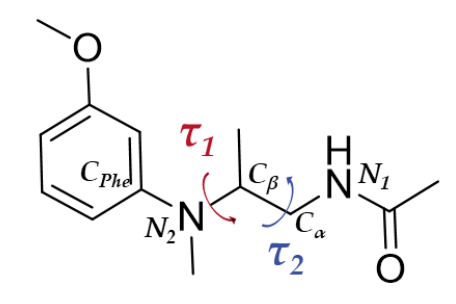
Figure 3. Representation of τ 1 (C Phe –N 2 –C β –C α ) and τ 2 (N 2 –C β –C α –N 1 ) dihedral angles.